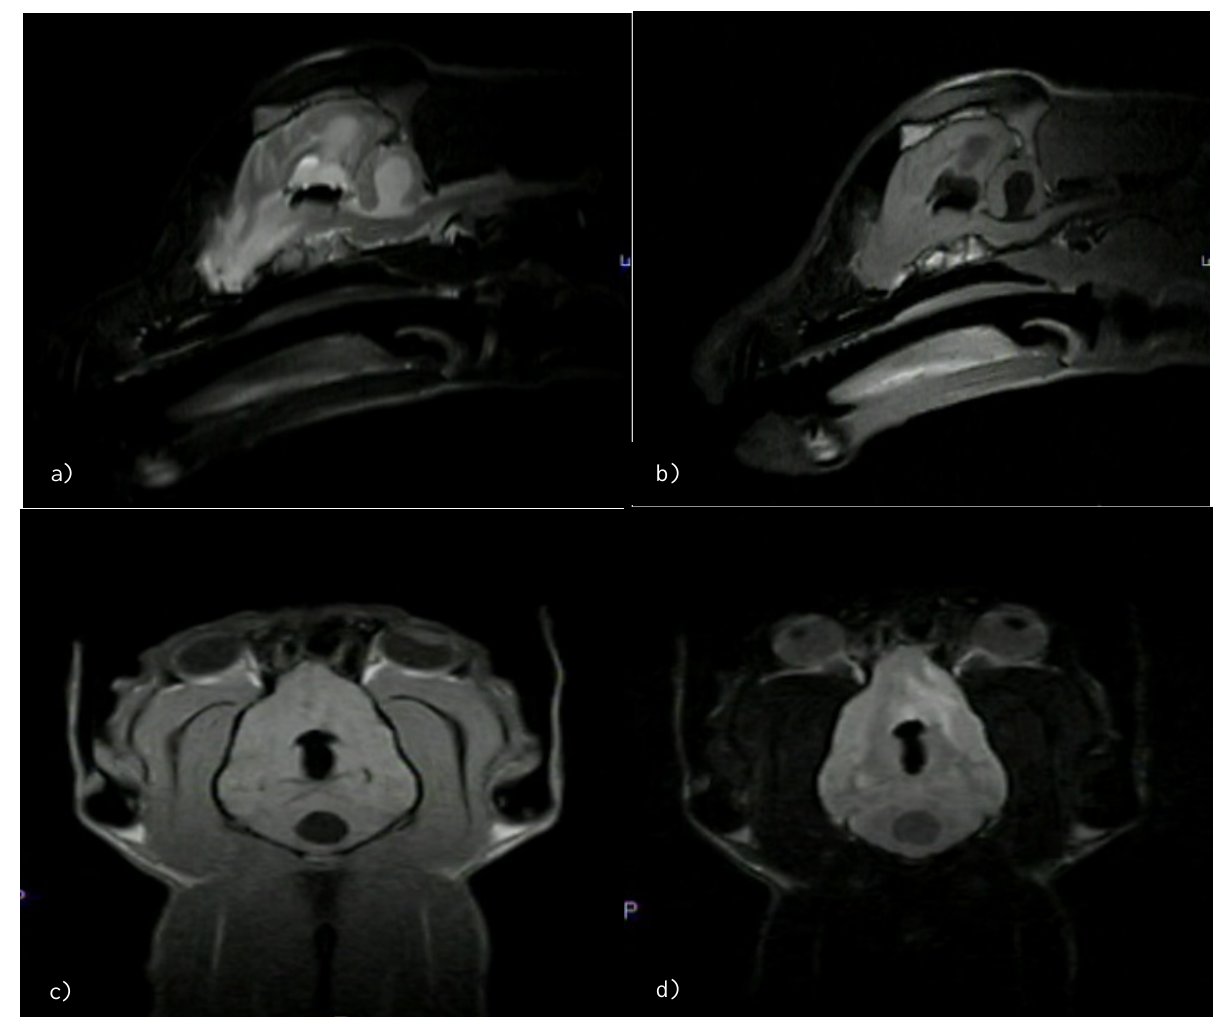
Fig. 2. Magnetic resonance imaging of the dog with post-traumatic changes in the brain (24 hours after injury) Note : a, b – sagittal section at the level of the left lateral ventricle of the brain in T2, T1 modes; c, d – coronary section at the level of the fourth ventricle of the brain and cystic cavity in T1, T2 modes (MRI